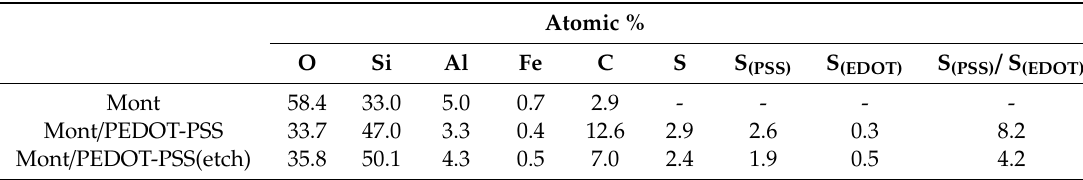
Table 3. X-ray photoelectron spectroscopy (XPS) atomic surface chemical composition of Mont clay before and after electropolymerization.